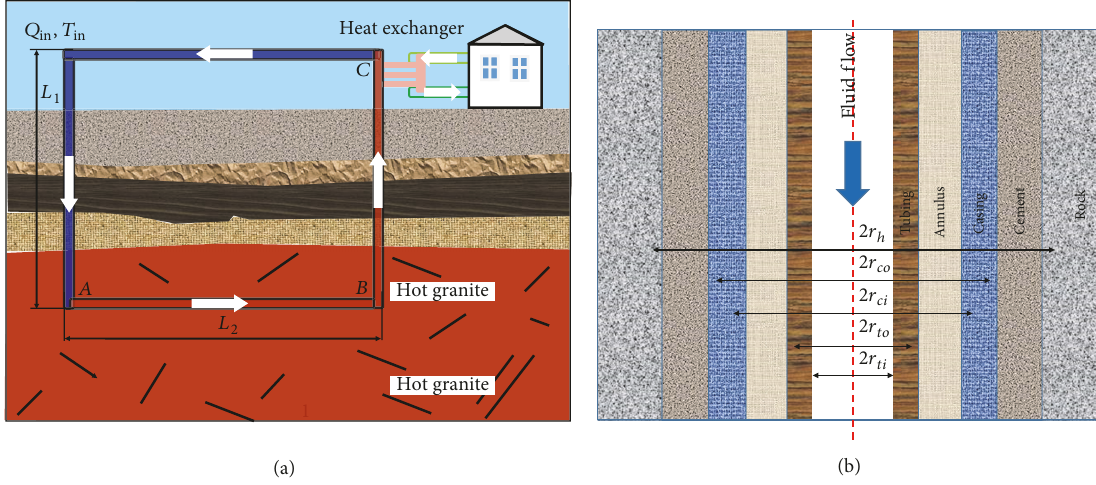
Figure 1: Model geometry. (a) Injection well system and (b) cross section of the well